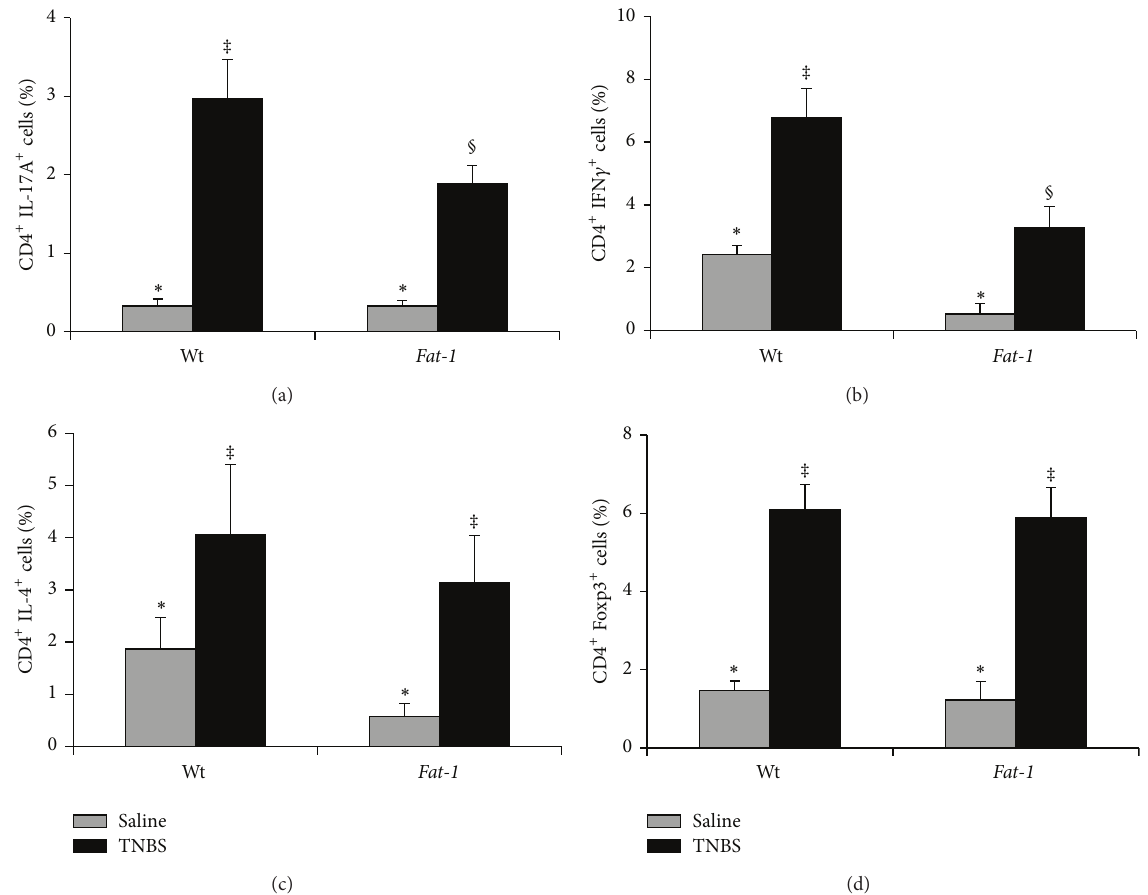
Figure 2: Percentage of colon lamina propria CD4 + T cell subsets in Wt and Fat-1 TNBS-treated mice (black bars, 𝑛 = 8 –16 pooled samples/genotype comprised of 2-3 colons) and saline controls (grey bars, 𝑛 = 4 pooled samples/genotype). (a) Th17 cells (CD4 + IL-17A + ), (b) Th1 cells (CD4 + IFN 𝛾 + ), (c) Th2 cells (CD4 + IL-4 + ), and (d) Tregs (CD4 + Foxp3 + ). Data were analyzed by two-way ANOVA (main effects: genotype and treatment); bars represent means ± SEM. Bars not sharing a symbol differ ( 𝑃 ≤ 0.05